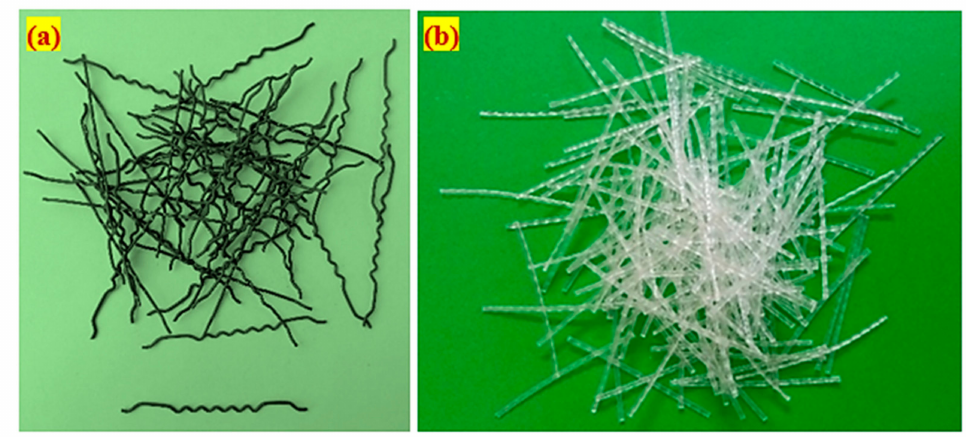
Figure 5. Fiber appearance: ( a ) hybrid shape of hooked-end crimped and ( b ) macro polypropy- lene